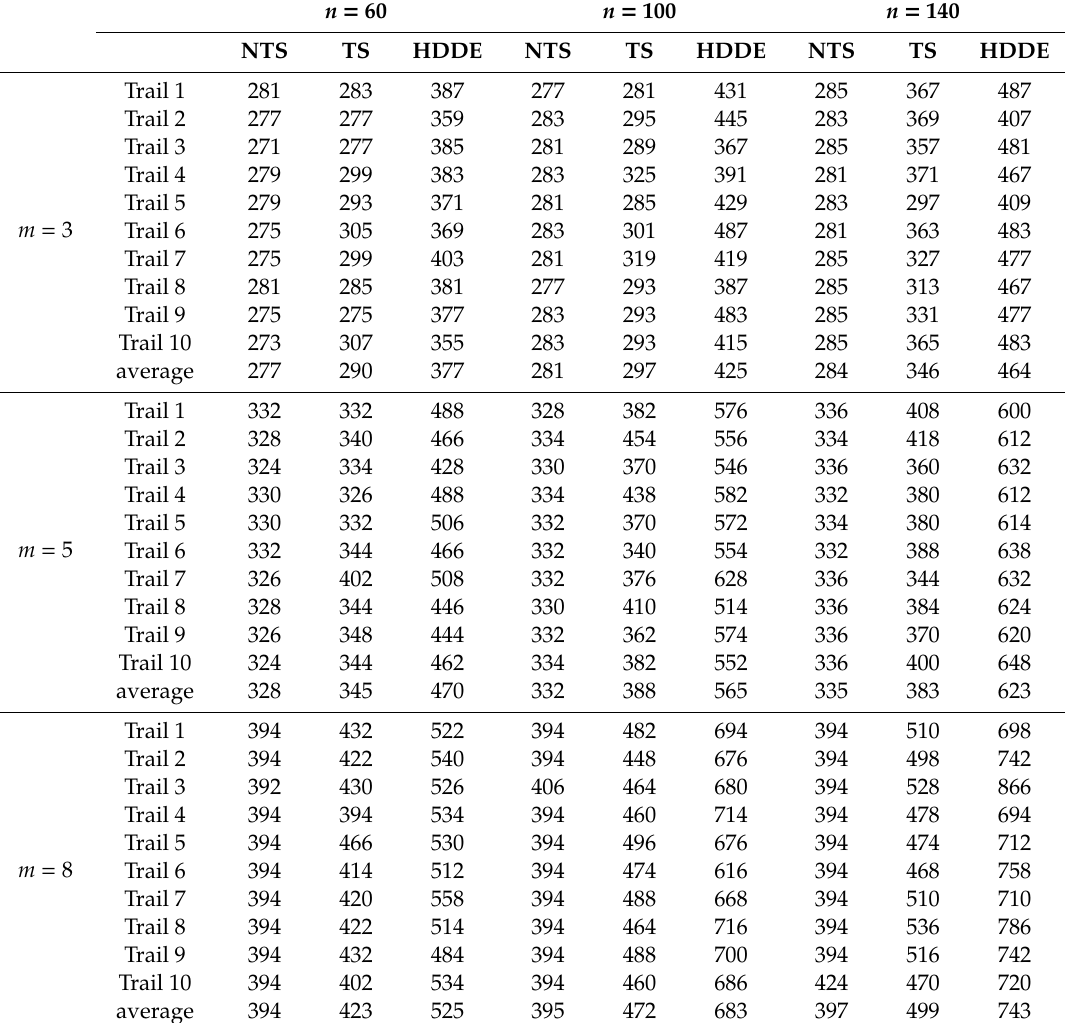
Table 2. Computational results of the NTS algorithm, tabu search (TS) algorithm, and di ff erential evolution algorithm with a local search strategy (HDDE) regarding the final objective value.